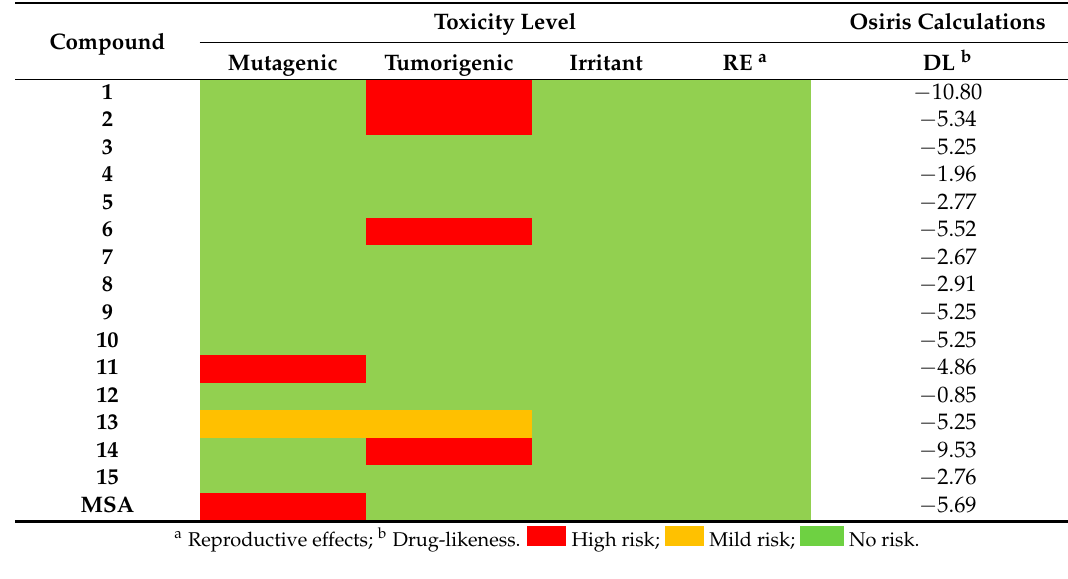
Table 3. Predicted toxicity of the compounds according to Osiris DataWarrior-based calculations.